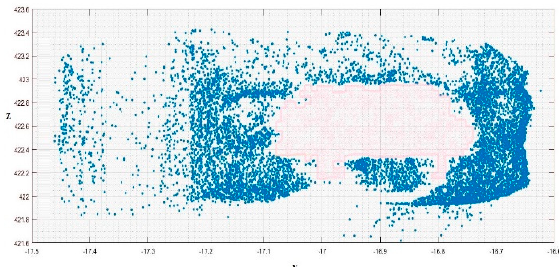
Figure 20. Hole detection in window patches on (y-z) plane. Units are in m.